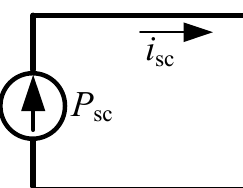
Figure 5. Equivalent model of battery and bidirectional DC/DC converter.